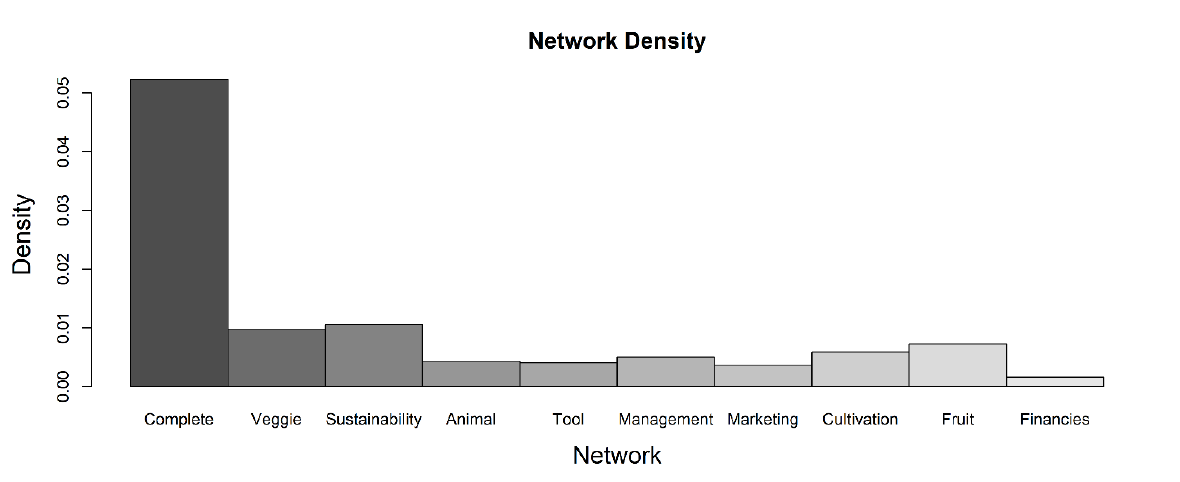
Network Density of Complete and Individual Networks